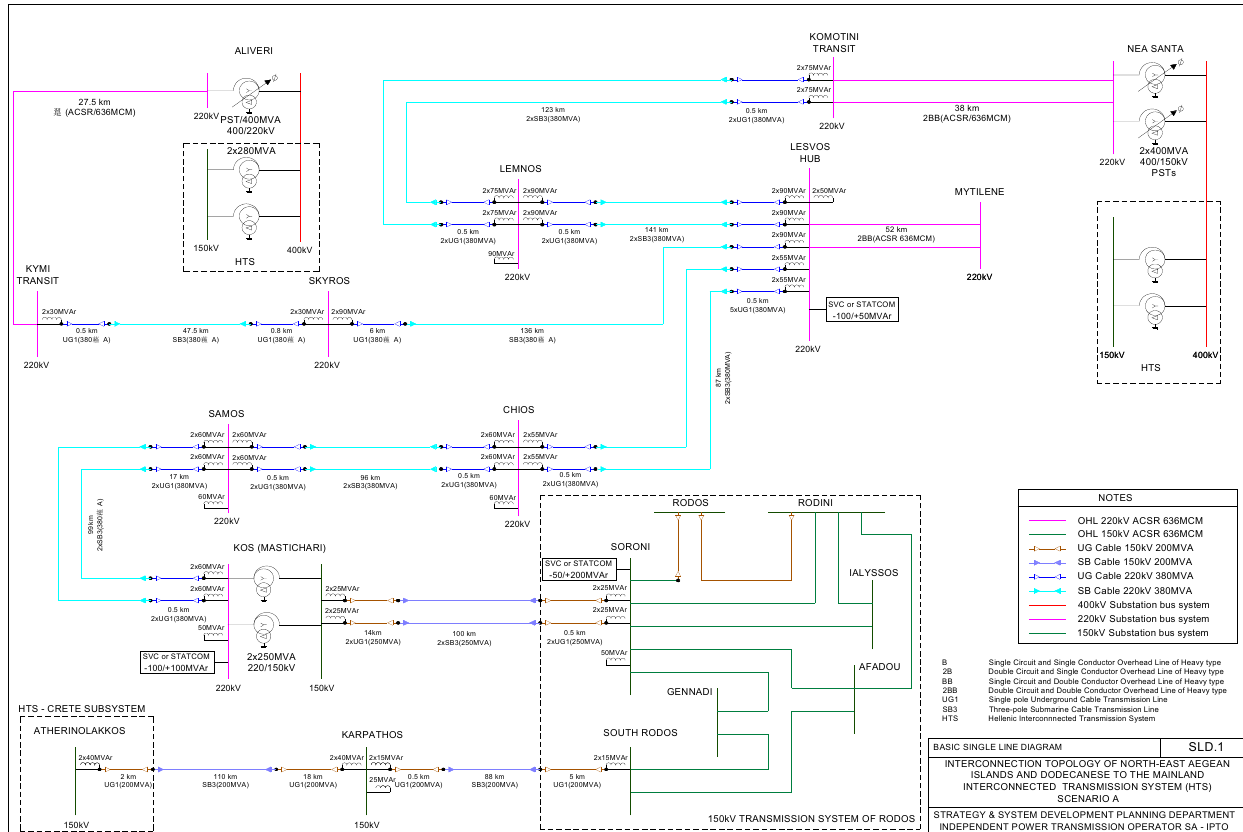
Figure 3. Single line diagram of the Scenario A (HVAC interconnection topology).